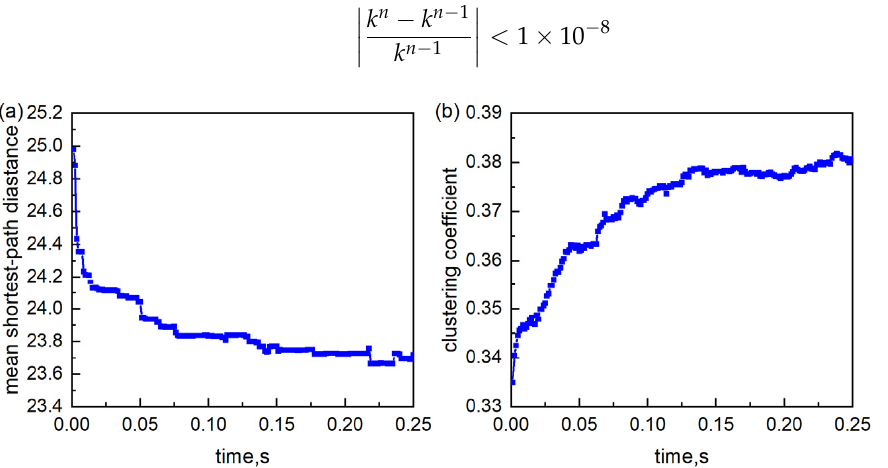
Figure 9. The network parameters change over time for porous media. ( a ) mean shortest-path distance. ( b ) clustering coefficient.